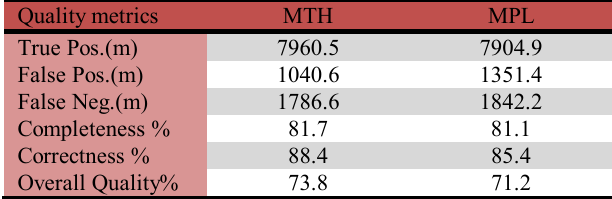
Table 2. A comparison of the proposed method (MPL) and MTH for road extraction after primitives